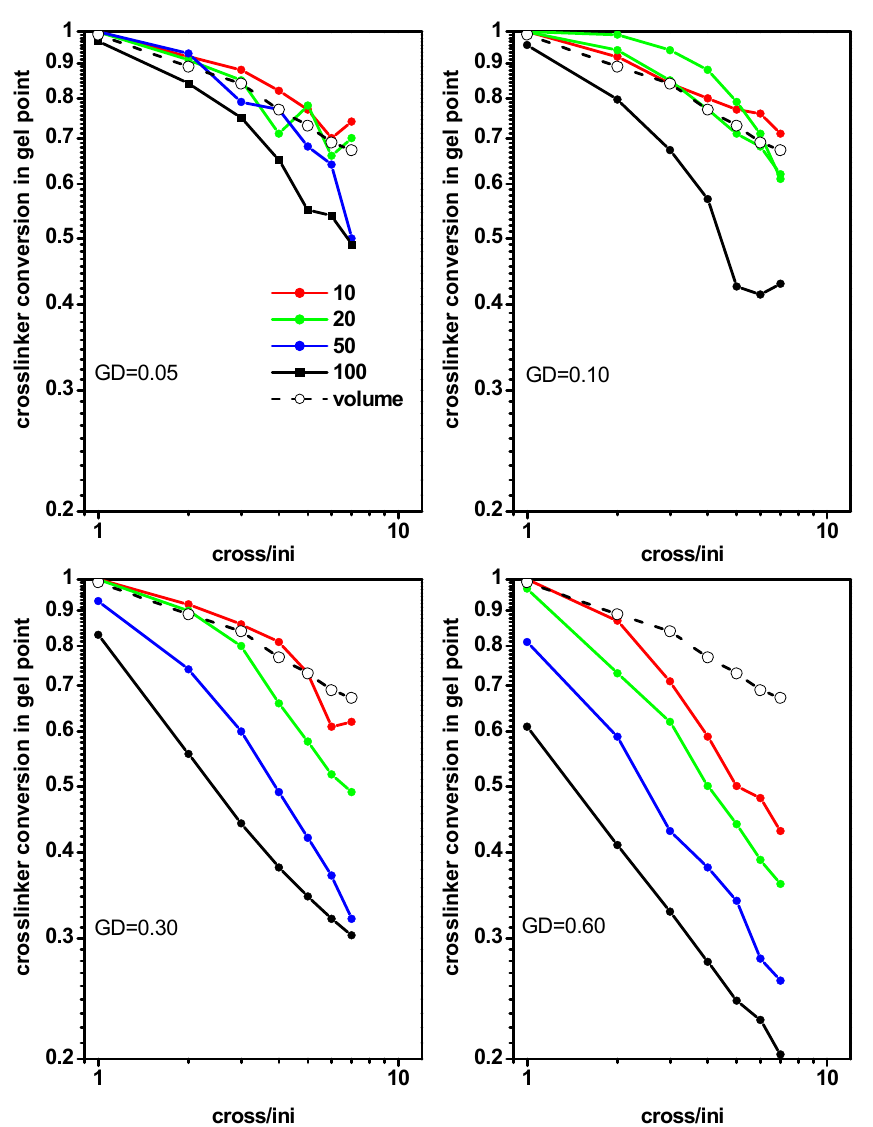
Figure 11. The conversion of cross-linker at the gel point for polymerization of grafted chains in a slit as a function of the ratio [Ini]/[X] for different grafting densities. The widths of the slit are given in the inset. The cross-linker conversion at gel point for a free volume are marked by the dashed line.